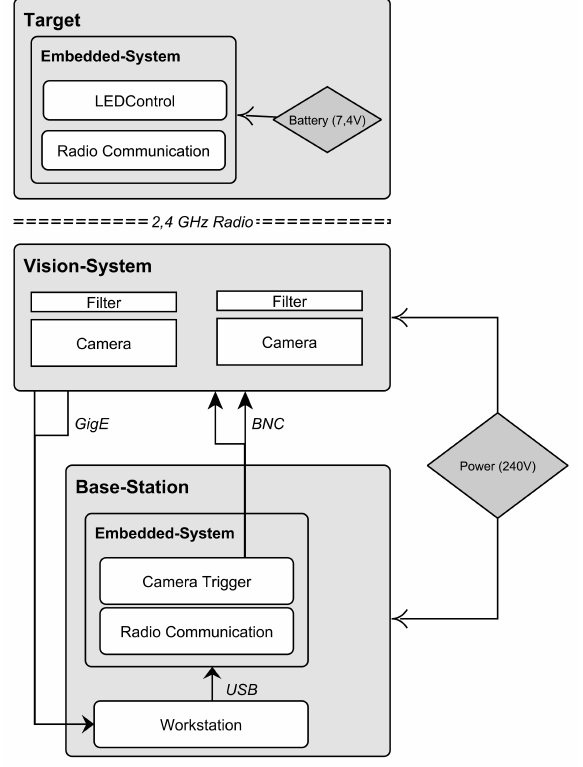
Figure 11. The cabling of the hardware